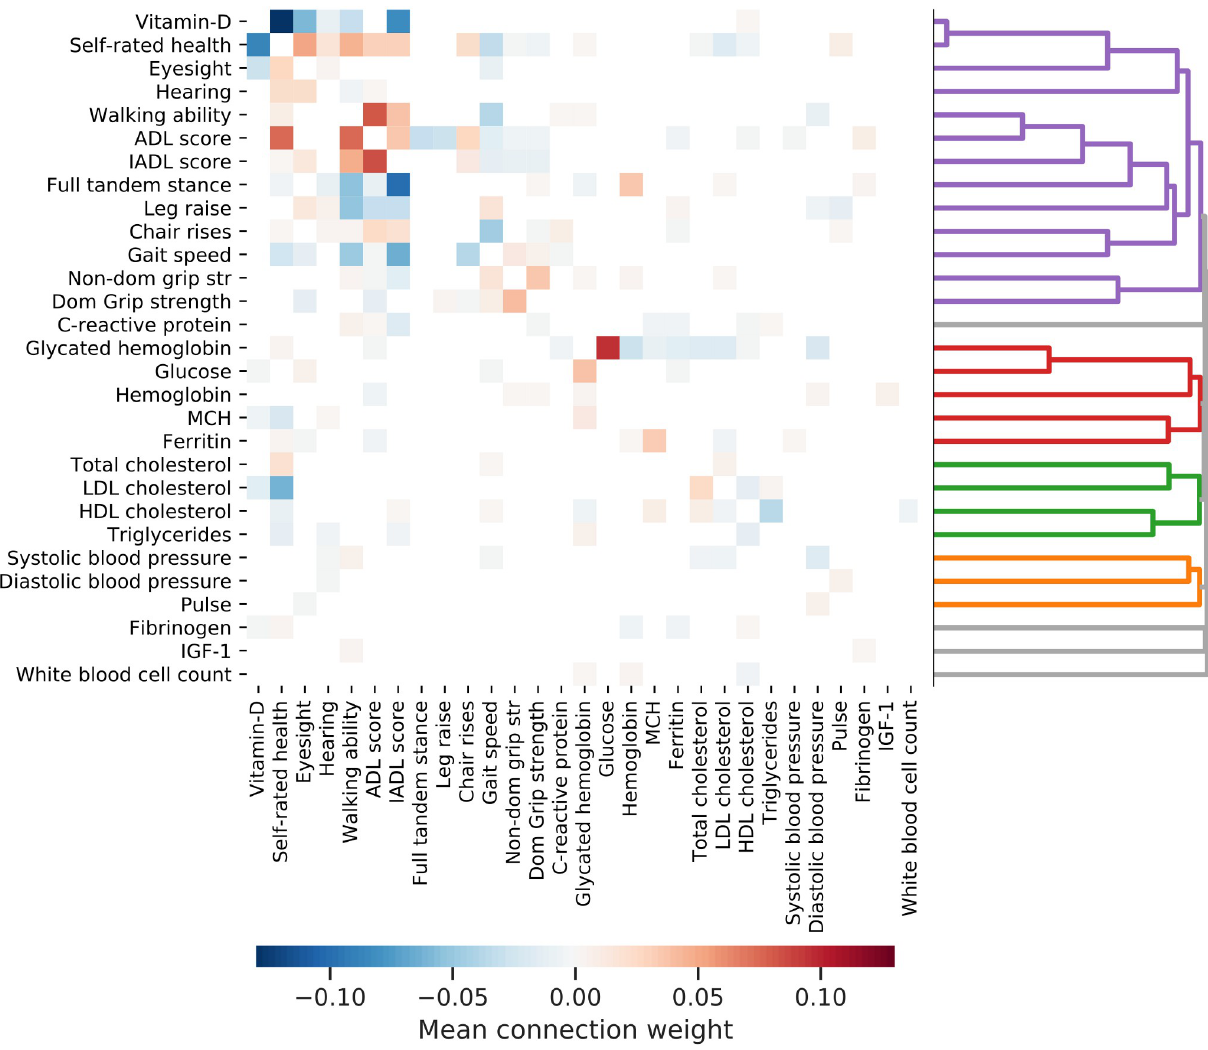
Fig 4. Inferred interaction network. Heatmap of the posterior mean value of the robust network weights. Weight directions are read from the horizontal axis ( j ) towards the vertical ( i ), W . The sign and color of the weight signify the direction of effect—a positive weight implies that an increase in a i j variable along the horizontal axis influences the vertical axis variable to increase. A negative weight implies that an increase in a variable along the horizontal axis influences the vertical axis variable to decrease. Hierarchical clustering is applied to the absolute posterior mean of the robust weights to create a dendrogram (at